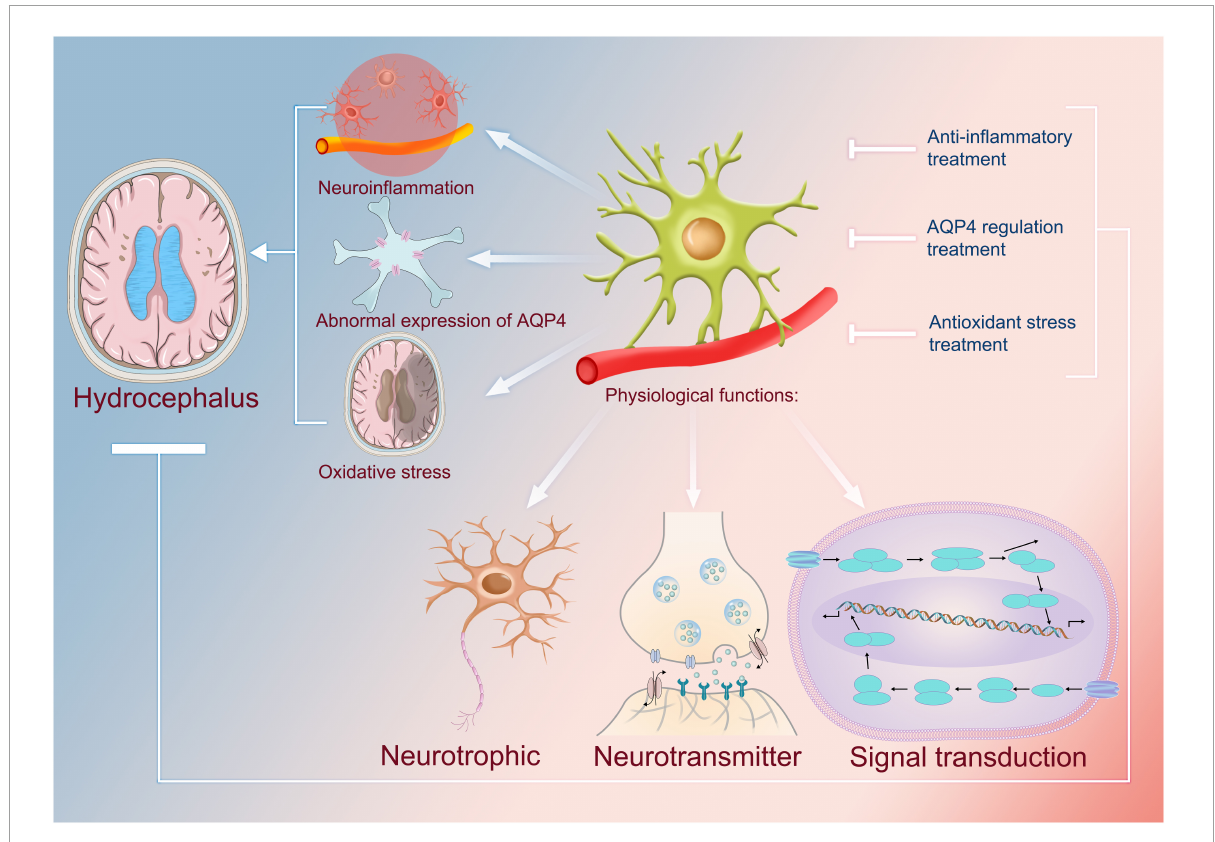
FIGURE2 Physiological functions of astrocytes and their uses as targets in the treatment of hydrocephalus. The physiological functions of astrocytes include neurotrophic, neurotransmitter, and cellular signal transduction. It has been found that abnormal astrocytes are closely associated with the formation of hydrocephalus, and for some of the mechanisms identified so far, they can be involved in the development of neuroinflammation; therefore, anti-inflammatory therapies that use astrocytes as targets can be one of the means by which we treat hydrocephalus. Astrocytes are capable of causing abnormal overexpression of AQP4, which in turn leads to excessive accumulation of cerebrospinal fluid and causes hydrocephalus. Therefore, using astrocytes as a target to regulate the expression of AQP4 can also regulate the production of cerebrospinal fluid, which in turn can be used to treat hydrocephalus. In addition, astrocytes are also associated with oxidation, which contributes to hydrocephalus. Thus, it is safe to say that antioxidant therapy associated with them may be an effective treatment. AQP4, aquaporin